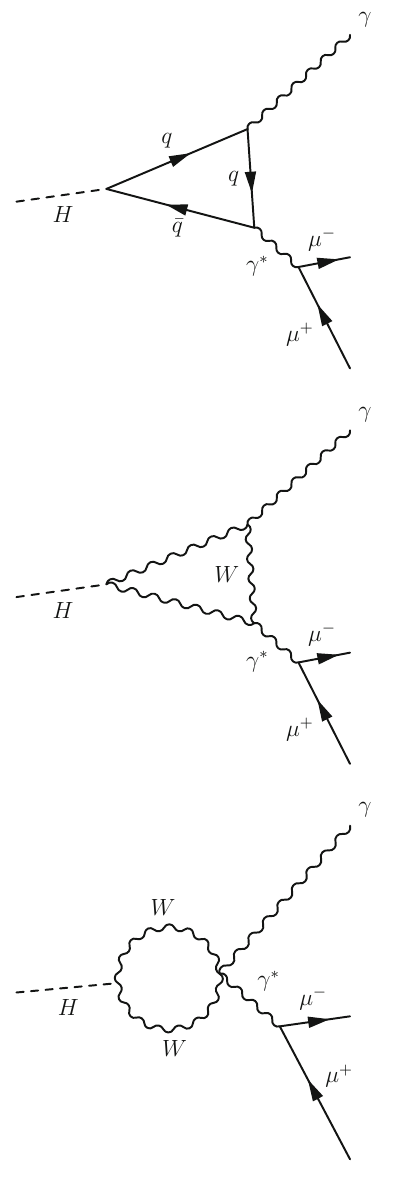
Fig. 3 The lowest order Feynman diagrams for the Higgs boson Dalitz decay of H → γ ∗ γ → μμγ . The background exhibits a peak in m μμγ at the Higgs boson mass